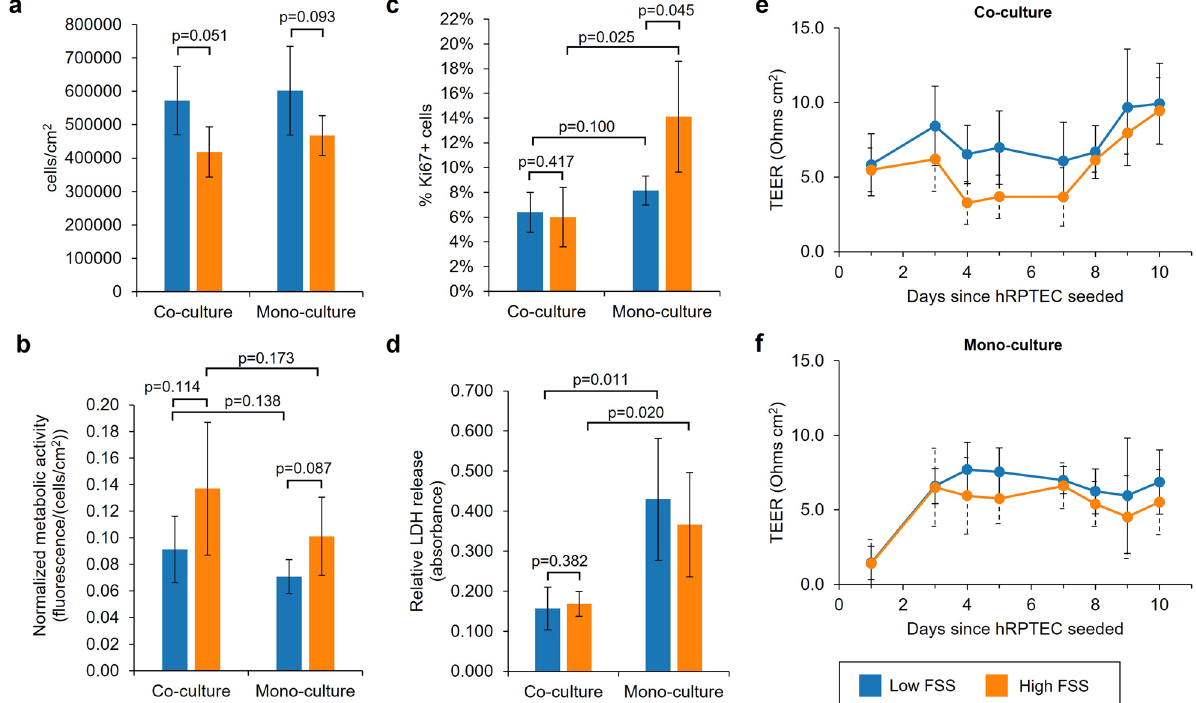
Figure 2. PREDICT96 facilitates hRPTEC characterization under multiple model conditions. ( a ) hRPTEC densities in the membrane overlap region are similar in co- and mono-culture conditions but tend to be higher in low FSS. ( b ) Relative bulk metabolic activity of hRPTEC normalized to cell density suggests higher metabolic rates among cultures in high FSS. ( c ) Percent of cells positive for proliferation marker Ki67 shows significantly higher proliferative activity among mono-cultures in high FSS ( p = 0.025) and slightly higher rates among mono- cultures in low FSS ( p = 0.100) compared to co-cultures, n = 3 images per device (see Methods). ( d ) Relative LDH release at baseline conditions highlights significantly greater cell death in mono-culture compared to co-culture in low FSS ( p = 0.011) and in high FSS ( p = 0.020). ( a - d ) n = 3 devices per condition, p values based on one-sided Students’ t -test, α = 0.05. ( e ) Average TEER of co-culture devices under baseline conditions showed minimal differences in barrier integrity after 10 days relative to FSS ( n = 33 devices per FSS up to day 7, n = 6 on days 8–10). ( f ) Average TEER of mono-culture devices under baseline conditions showed negligible differences in barrier integrity relative to FSS and similar magnitude as co-culture devices ( n = 9 devices per FSS up to day 7, n = 3 on days 8–10). N = 1 experimental replicate. Bars represent mean ± SD of biological